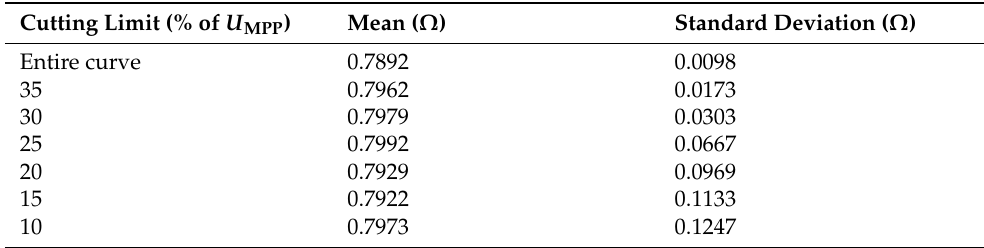
Table 3. Statistical quantities of the fitted series resistance for different cutting limits based on MPP voltage during the 40 min measurement period.